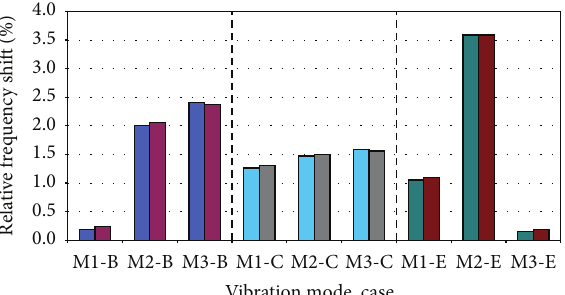
Figure 8: The relative frequency shifts analytically derived (left bars for each mode) and evaluated by FEA (bars positioned at right) for the mass decrease on an extended region.